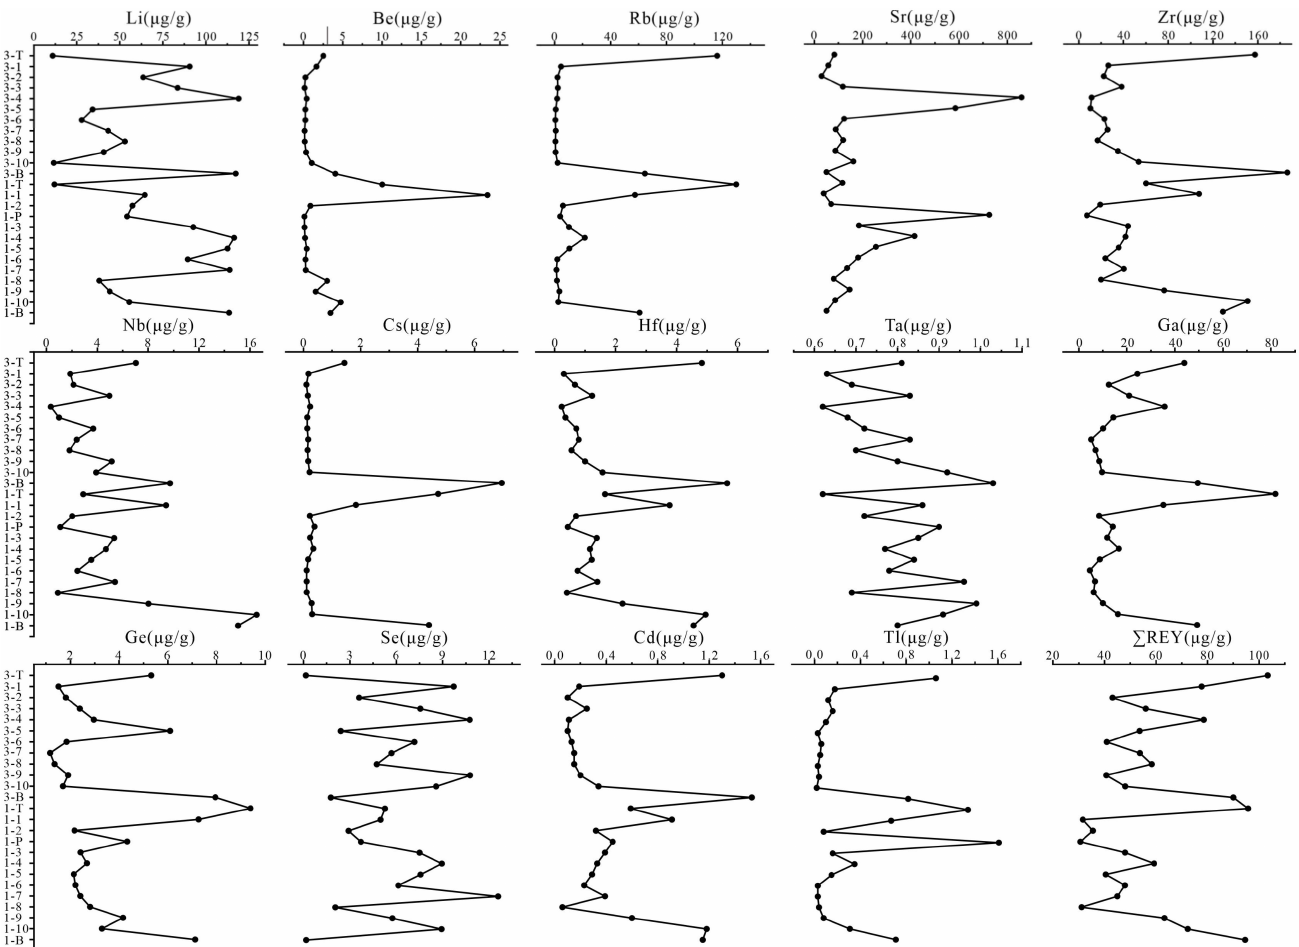
Figure 5. Vertical distribution of TREs in the deeply buried group Shanxi coal seam of Huainan coalfield ( µ